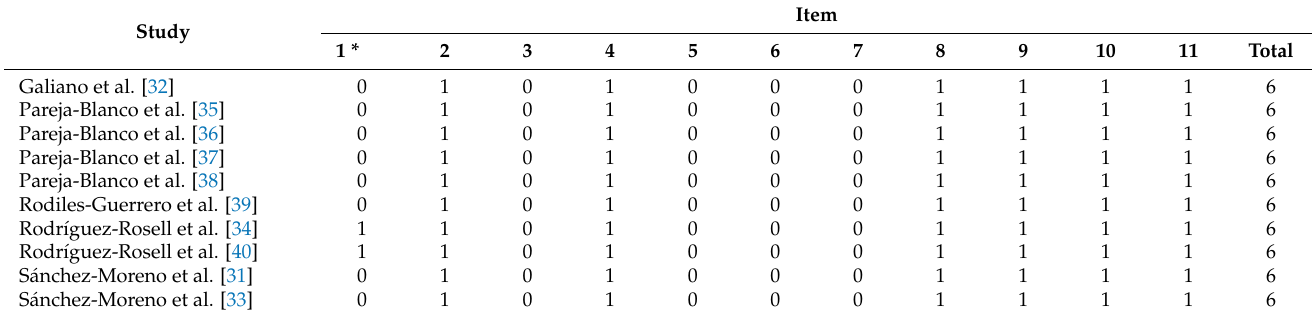
Table 1. Results of the PEDro scale showing the risk of bias in potential studies.